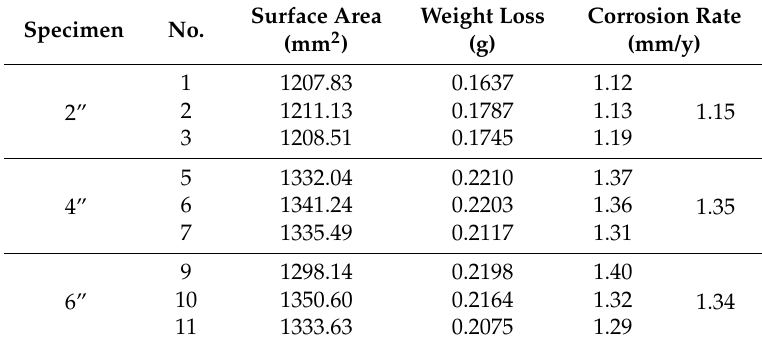
Table 5. Corrosion test results of full immersion.